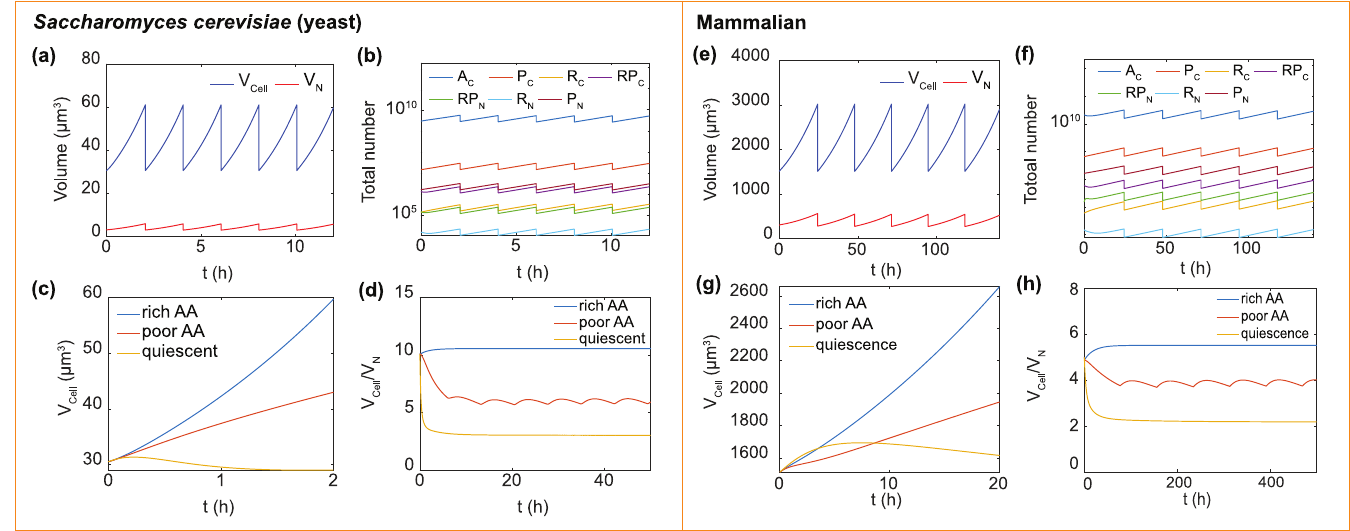
Fig 3. Model results for cell and nuclear volumes of Saccharomyces cerevisiae (yeast) and HeLa (mammalian) over several cell cycles. Here the cell divides when the cell volume doubles. (a) The cell volume ( V Cell = V C + V N ) and nuclear volume ( V N ) for a repeatedly dividing cell. (b) The number of cell components (amino acids, proteins, ribosomal proteins and ribosomes) for successive rounds of cell division. (c) The cell volume grows exponentially if amino acid is rich, and � t computed growth trajectory is approximately linear if amino acid is poor and � t the C/N ratio ( V Cell / V N ) reaches a constant. In the quiescent case, the cell growth rate is zero, and the C/N ratio is small. (e)-(h) Corresponding results for mammalian cell. Parameters used are listed in Tables 1 and 2.